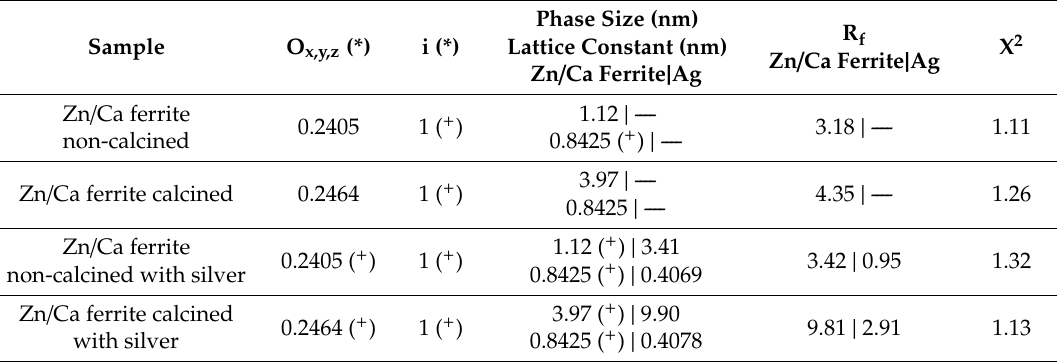
Table 2. Selected Rietveld analysis parameters.